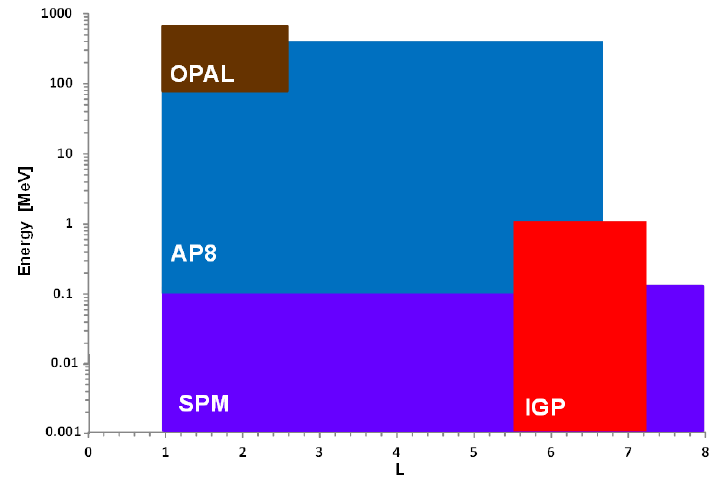
Figure 8. Energy and L coverage of the different models integrated in GREEN- p